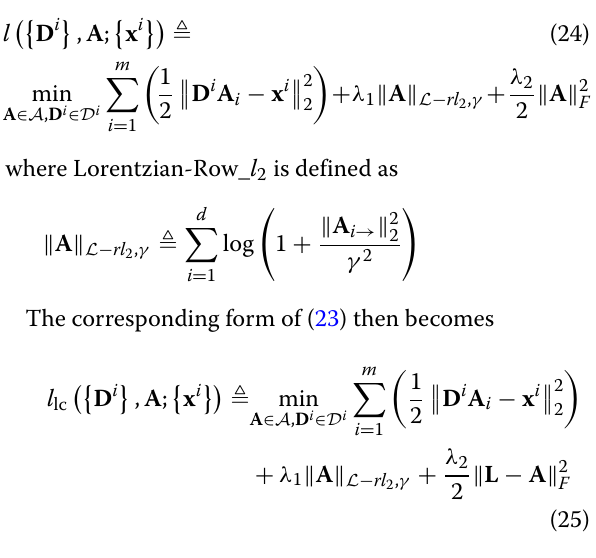
level grows. As a result, MPENet-d outperforms